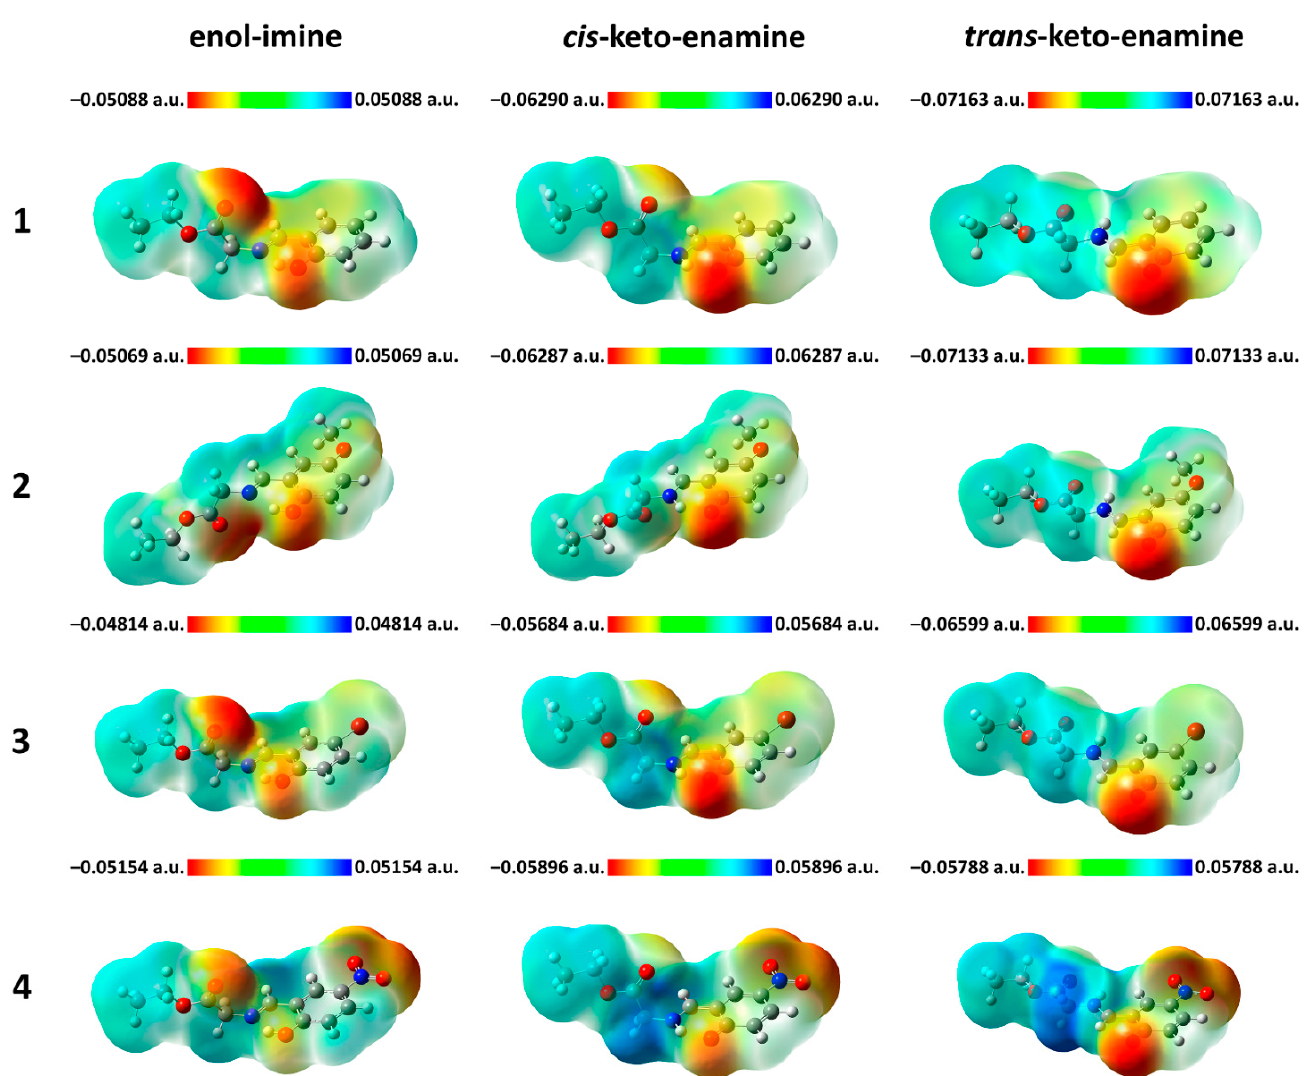
Figure 10. Views of the molecular electrostatic potential surface of 1 – 4 , obtained by using the B3LYP/6-311++G(d,p) method.